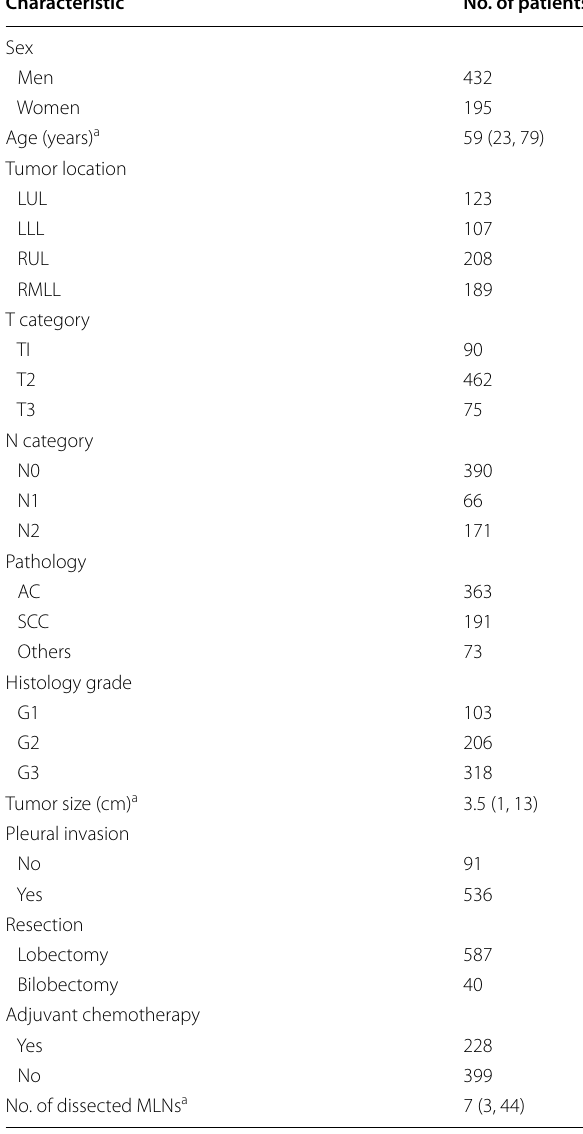
Table 1 Clinicopathologic characteristics of the